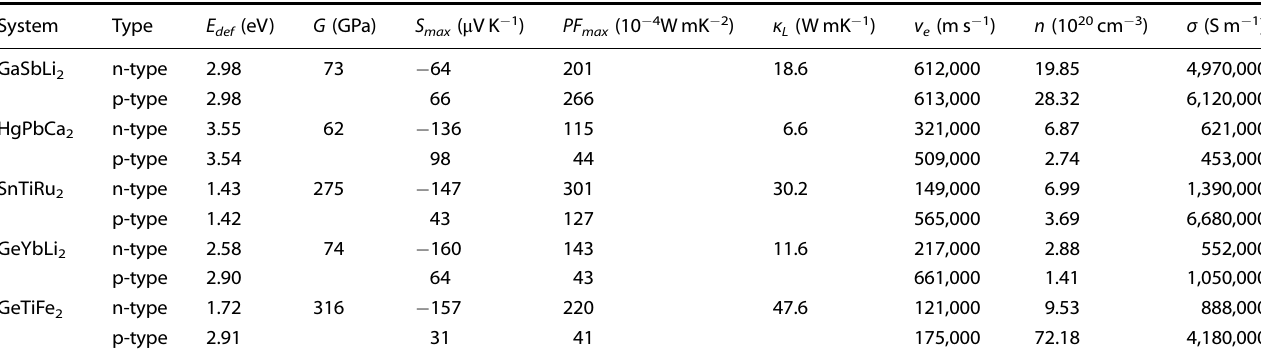
Table 1. Parameters of fi ve screened Heusler systems for active cooling application.